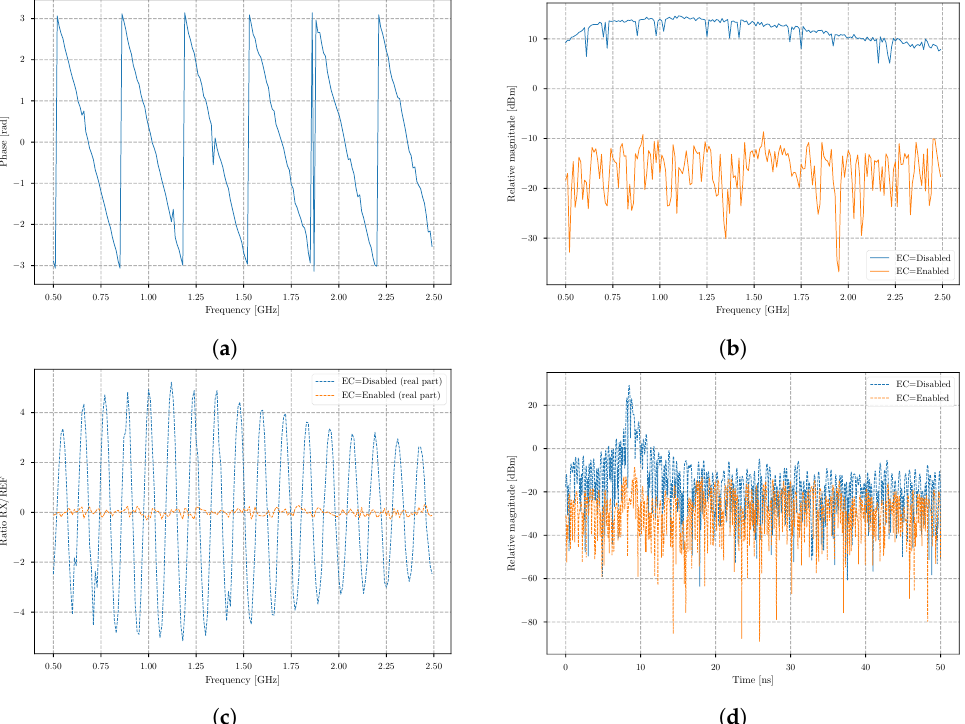
Figure 5. Obtained results when the TX synthesizer and the EC synthesizer are connected with a 1 m-long coaxial cable ( a ) Phase shift through the frequency. ( b ) Magnitude measured with the receiver when EC is disabled and enabled. ( c ) The real part of the measured complex-valued signal with the receiver when EC is disabled and enabled. ( d ) The signal magnitude in the time domain of the acquisition with the receiver when EC is disabled and enabled.